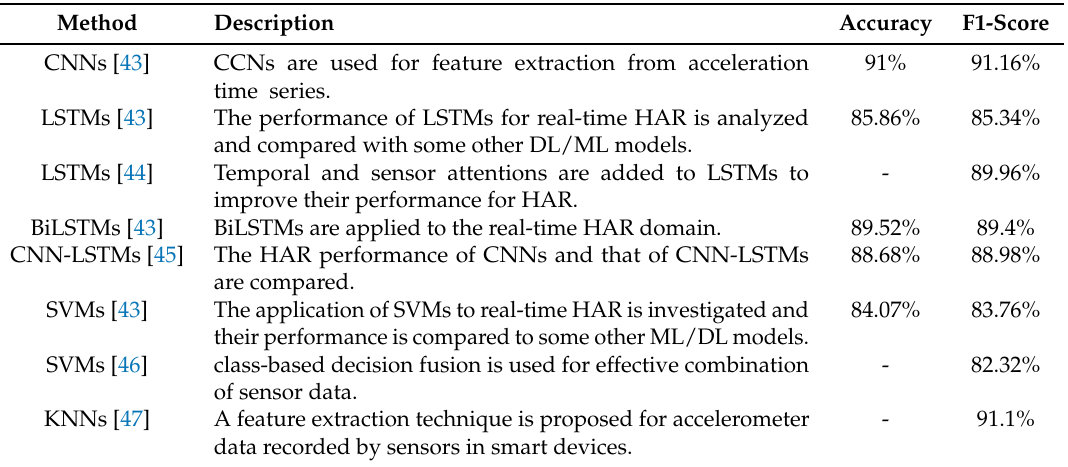
Table 8. Classification methods applied to the PAMAP2